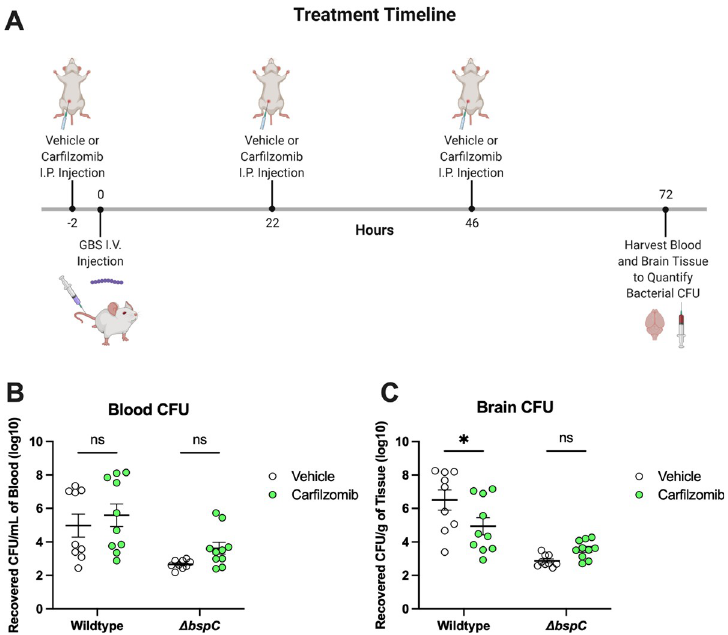
Fig 7. Carfilzomib Prevents GBS Brain Entry in vivo . (A) Schematic generated using BioRender displaying the experimental design and injection/infection timepoints for the comparison of Carfilzomib or vehicle (10% DMSO in sesame oil) treatments. Mice were infected with ~8.5x10 8 CFU of either WT or Δ bspC GBS. Four WT GBS infected vehicle treated mice and three WT infected carfilzomib treated mice were euthanized early based disease severity. All remaining mice were euthanized at 72 hours post infection, at which time the brain tissues (B) and blood (C) were harvested for enumeration of bacterial CFU. Pooled data from two independent experiments is shown. Error bars indicate standard error of the mean. Statistical analysis: (A) Two-way ANOVA with Tukey’s multiple comparisons. � , P <